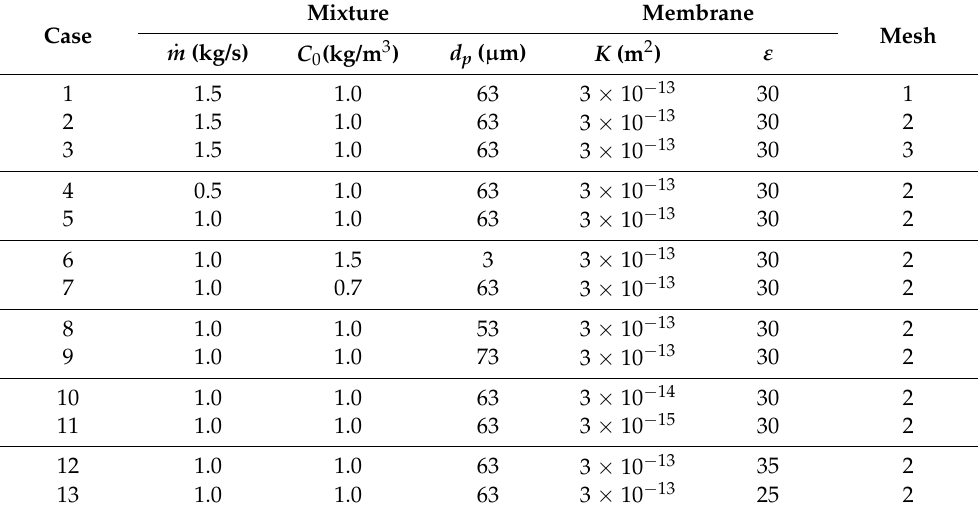
Table 6. Parameter data used in the simulations